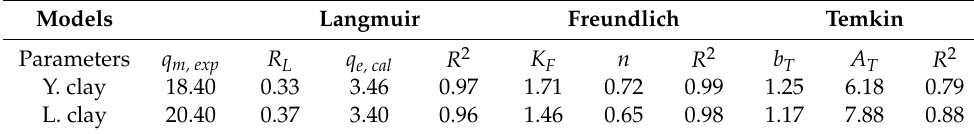
Table 5. Adsorption isotherm parameters calculated using linear regression analysis. Models Parameters